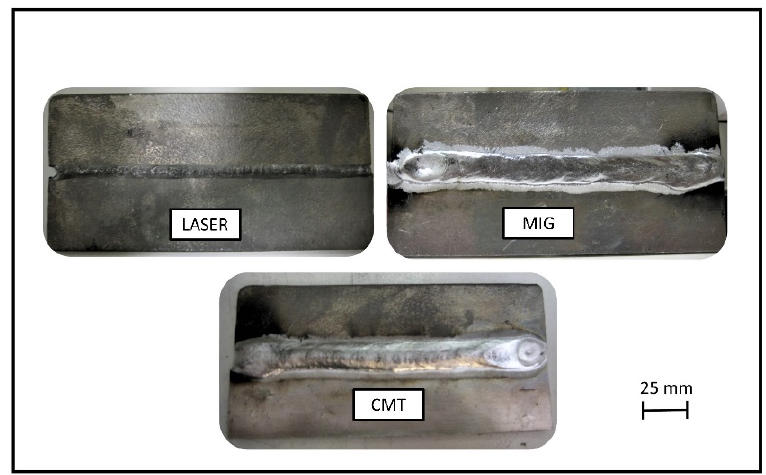
Figure 2. Example of the samples used for the different weld techniques.